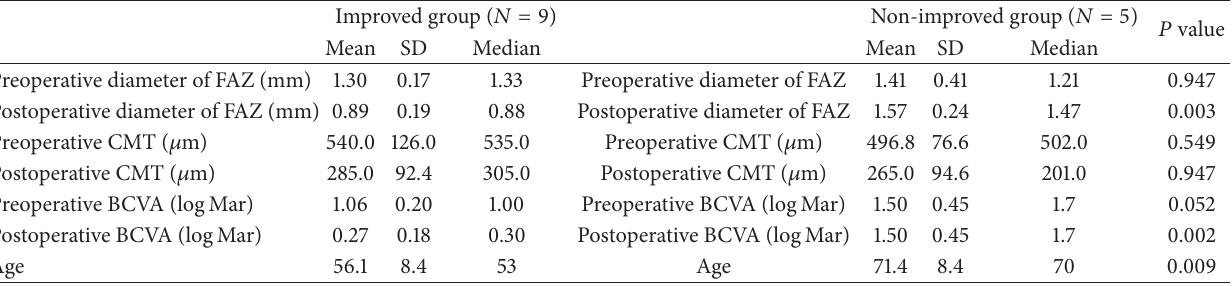
Table 4: Comparison of pre- and postoperative foveal avasculalr zone, pre- and postoperative central macular thickness and age in the improved and non-improved subgroups in the non-ischemic group.